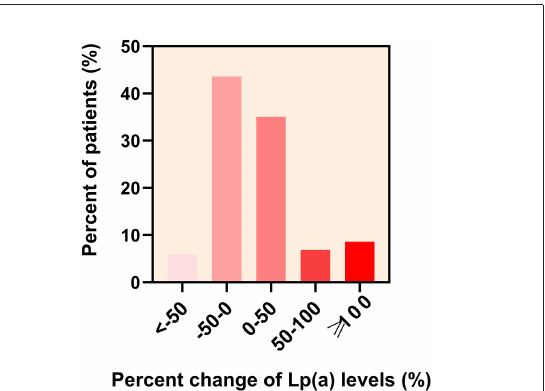
Distribution of the percent change of lipoprotein(a) [Lp(a)] levels in patients. The percent change of Lp(a) levels in statin-treated patients with first acute ischemic stroke at < − 50, − 50–0, 0–50, 50–100, and ≥ 100% was 5.9, 43.6, 35.0, 6.9, and 8.6%,